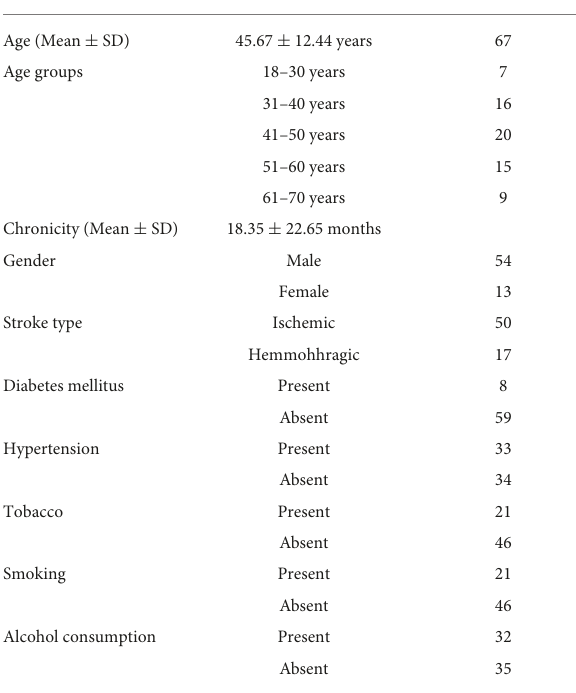
TABLE 1 Demographic and clinical characteristics of patients ( n =